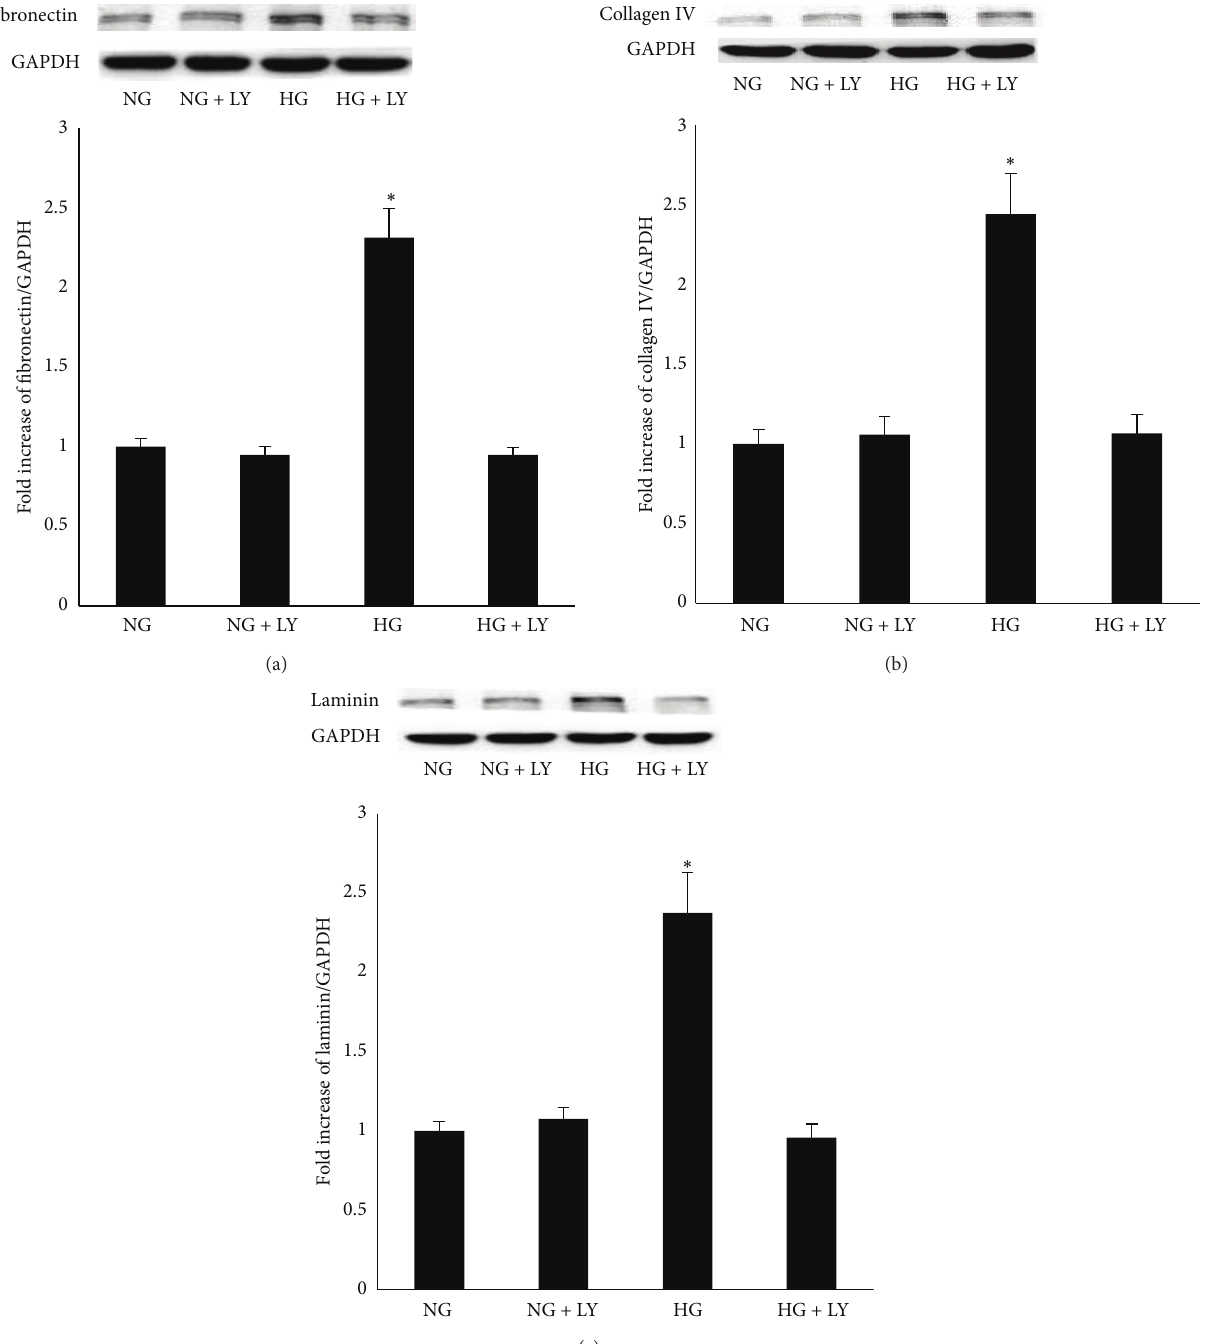
Figure 6: The protein level of fibronectin, collagen IV, and laminin was mediated by PI3K/Akt signaling pathway in RPE cells under high glucose conditions. (a, b, c) The protein expression of fibronectin, collagen IV, and laminin was significantly decreased when exposed to high glucose conditions for 24 h in RPE cells by pretreatment with 20 𝜇 M LY294002 for 12 h. ∗ 𝑃 < 0.01 versus NG or HG + LY. The data shown represent the mean ± SD of three independent